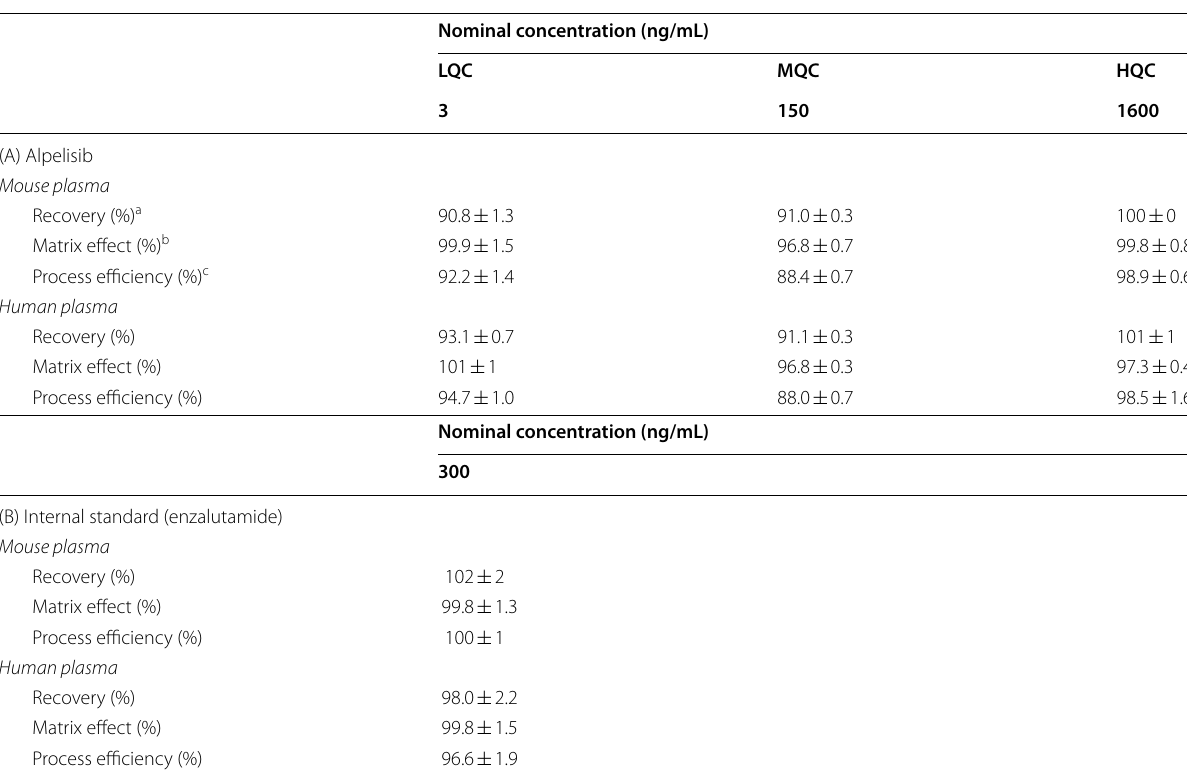
Table 2 Recovery, matrix effect, and process efficiency of alpelisib and the internal standard in mouse and human plasma (mean SD, n 3) ± =